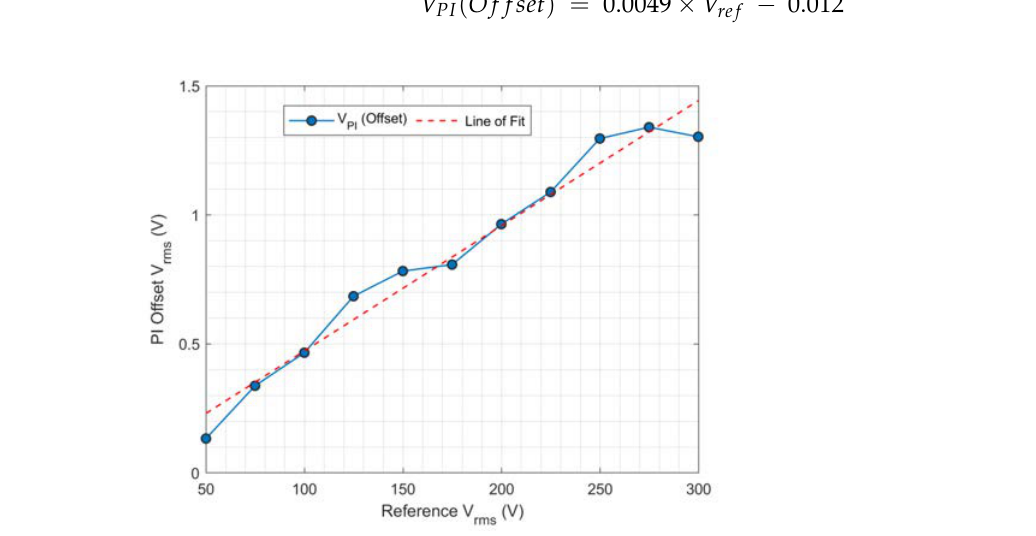
Figure 11. Relation between the rms power interface offset ( VPI ) based on reference voltage (V ref ) from the real-time simulator